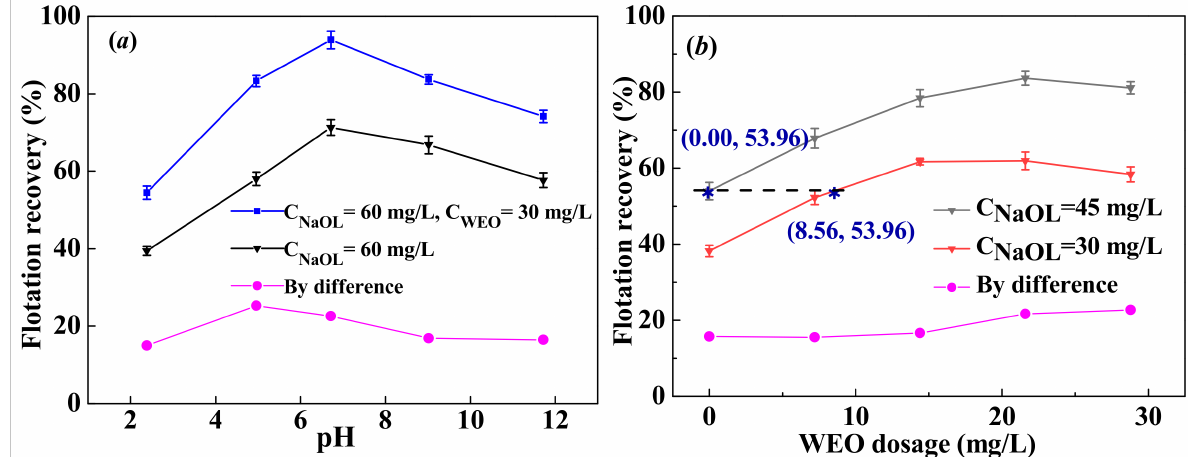
Figure 2. The flotation recovery of ilmenite at different pH ( a ) and collector dosage ( b